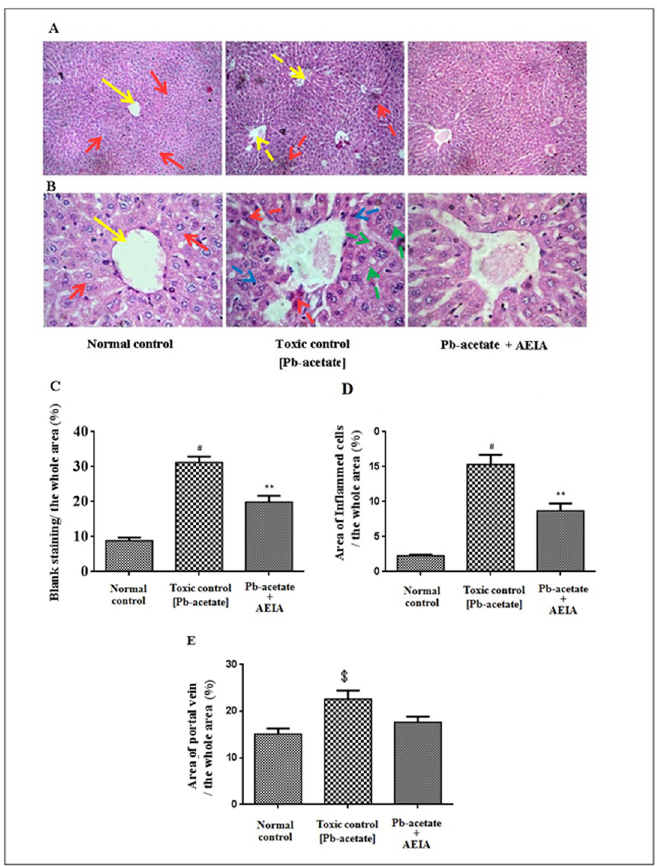
Fig 7. Histological sections 100 x (A) and 400 x (B) of livers of experimental mice in the absence (Pb- acetate) and existence of AEIA (Pb-acetate + AEIA). Untreated mice were kept as normal control to compare the structural changes caused by Pb-acetate. Yellow and red arrows represent normal portal vein and hepatocytes, respectively; dotted arrows represent the Pb-acetate mediated structural changes of portal vein (yellow), hepatocytes (red) with infiltrating leukocytes (blue) and lipid deposition (green). C. Hepatic lipid droplets accumulation was presented as the percentage of the blank area relative to the whole area of the photomicrograph (100 x, randomly selected area devoid of portal vein were selected). D. The incidence of inflammation was presented as the percentage of the inflamed hepatocytes region relative to the whole area of the photomicrograph (100 x, randomly selected area in devoid of portal vein were selected). E. The structural change of portal vein was represented as percentage of the blank area relative to the whole area of the photomicrograph (400 x, randomly selected areas containing one portal vein were selected). Values are expressed as mean ± SE, (n = 60). $ Values significantly differed from normal control (P < 0.05). # Values differ significantly from normal control (p < 0.01). ** Values significantly differed from Pb-acetate control (P <